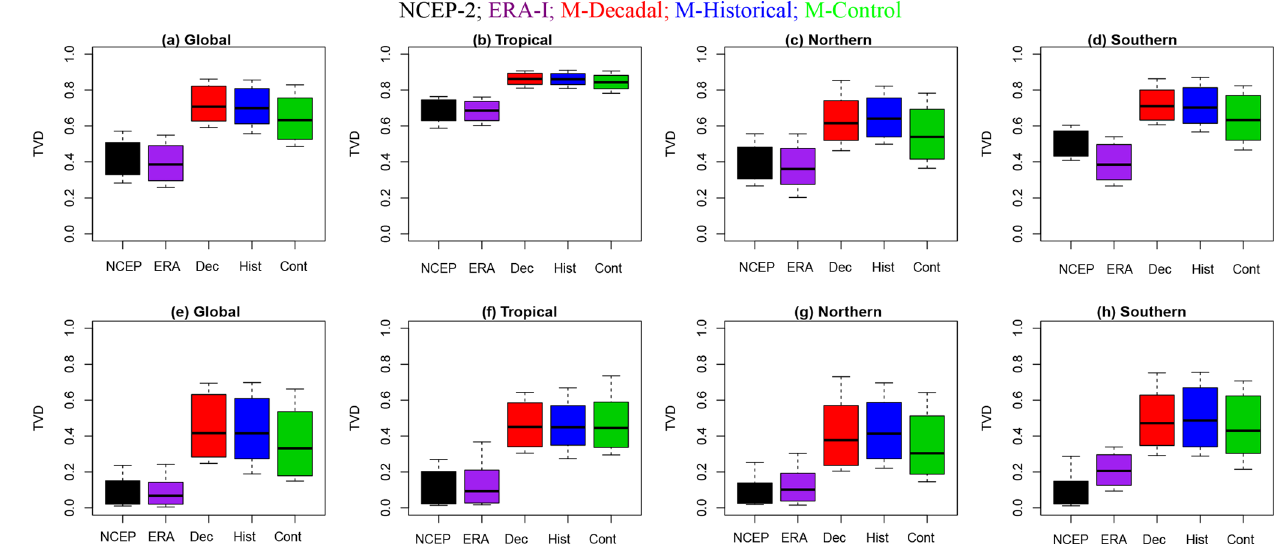
Figure 5. (a–d) TVD calculated from φ samples with white noise as the reference. (e–h) TVD calculated from φ samples with the MAP NCEP spectrum as the reference. Larger TVD values indicate higher discrepancy between spectral densities. Whiskers indicate the maximum and minimum values and boxes indicate the 95% posterior intervals. The scenario or observational product is indicated using colors. From left to right: global (a, e) , tropical (b, f) , Northern Hemisphere (c, g) , and Southern Hemisphere (d, h)